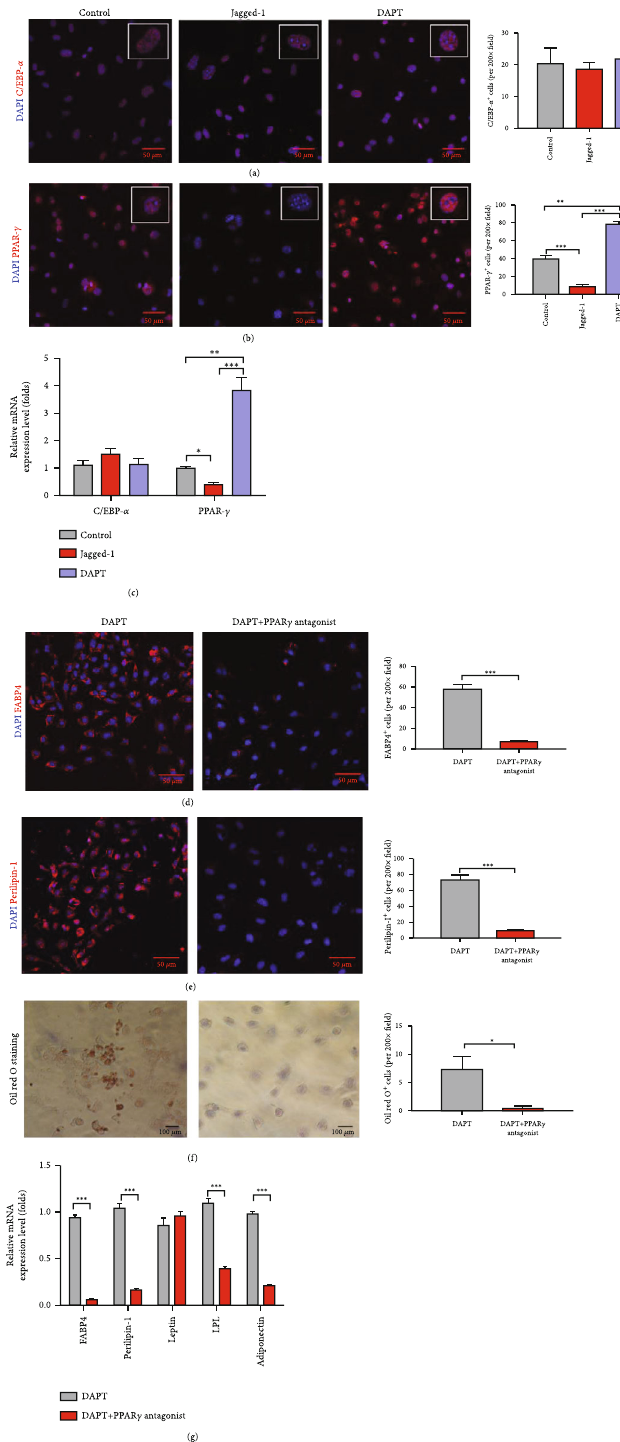
Figure 6: DAPT treatment upregulated the transcription factor PPAR- γ . (a, b) The crucial adipogenic transcription factors PPAR- γ and the C/EBP- α were determined by immuno fl uorescence staining after EPCs were cultured in adipogenic induction medium alone, with jagged-1 or with DAPT for 7 days. (c) The mRNA expression levels of PPAR- γ and C/EBP- α were determined by RT-PCR. (d, e) The adipocyte markers FABP-4 and perilipin-1 were determined by immuno fl uorescence. EPCs were cultured in adipogenic induction medium with DAPT alone or combined with PPAR- γ antagonists. (f) Lipid droplet accumulation was determined by Oil red O staining. EPCs were cultured in adipogenic induction medium with DAPT alone or combined with PPAR- γ antagonists. (g) The mRNA expression levels of adipocyte-related genes FABP4, perilipin-1, leptin, LPL, and adiponectin were determined by RT-PCR. The p values were calculated by t -test between 2 groups and by ANOVA among 3 groups. ∗ p < 0 : 05 , ∗∗ p < 0 : 01 , and ∗∗∗ p < 0 : 001 for pairwise comparison among the